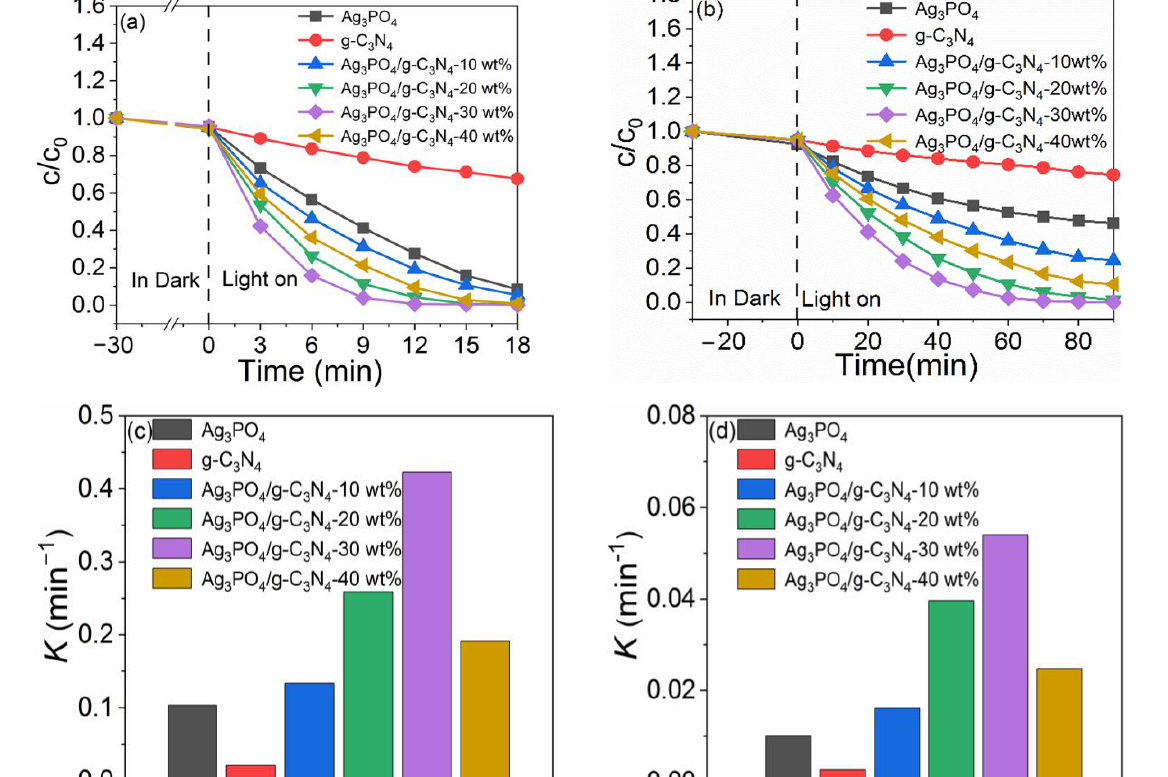
Figure 5. ( a , b ) Photocatalytic curves, ( c , d ) rate constants in the degradation of Rh B and phenol, with different g-C 3 N 4 content.